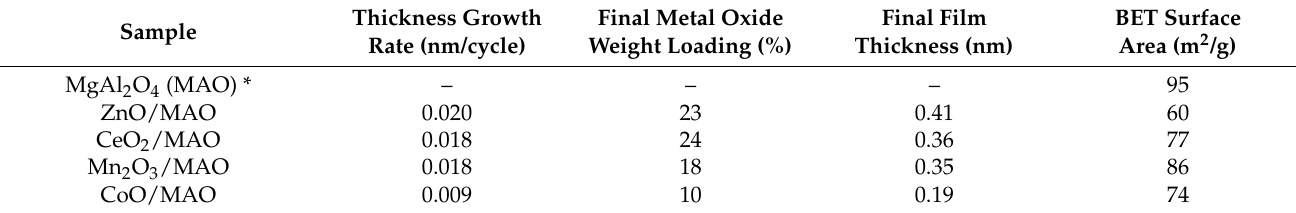
Table 1. Properties of the ALD-modified supports used in this study.